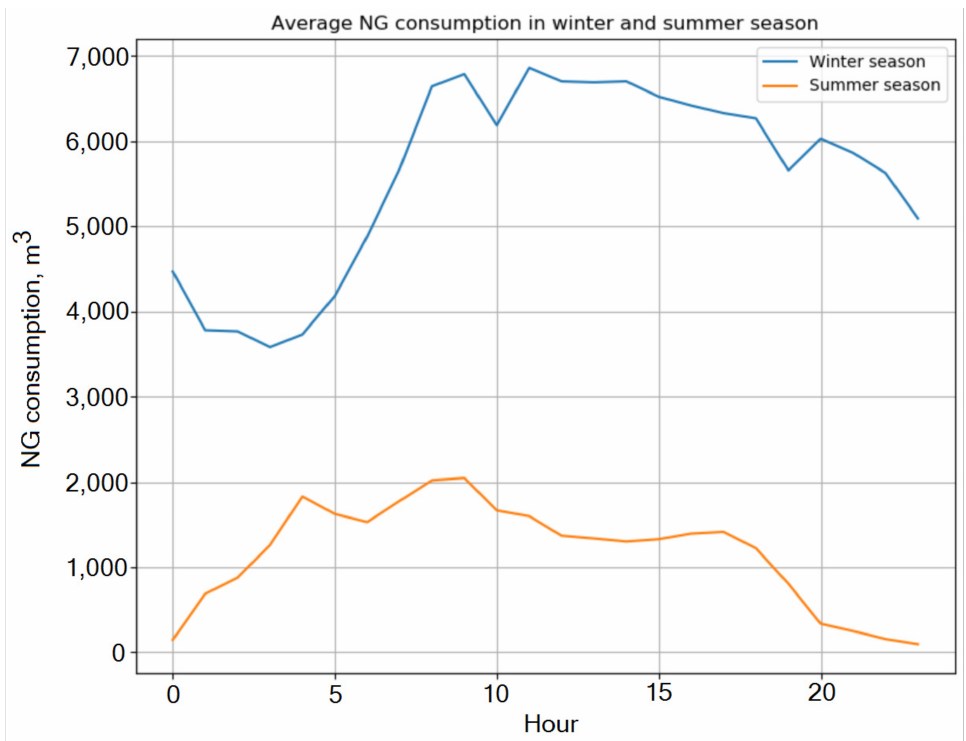
Figure 3. The average hourly gas consumption for collected data for one metering station in winter and in summer season.